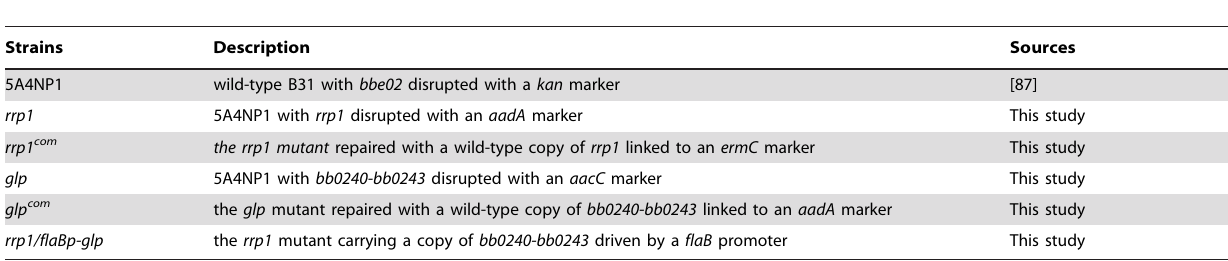
Table 1. B. burgdorferi strains used in this study.